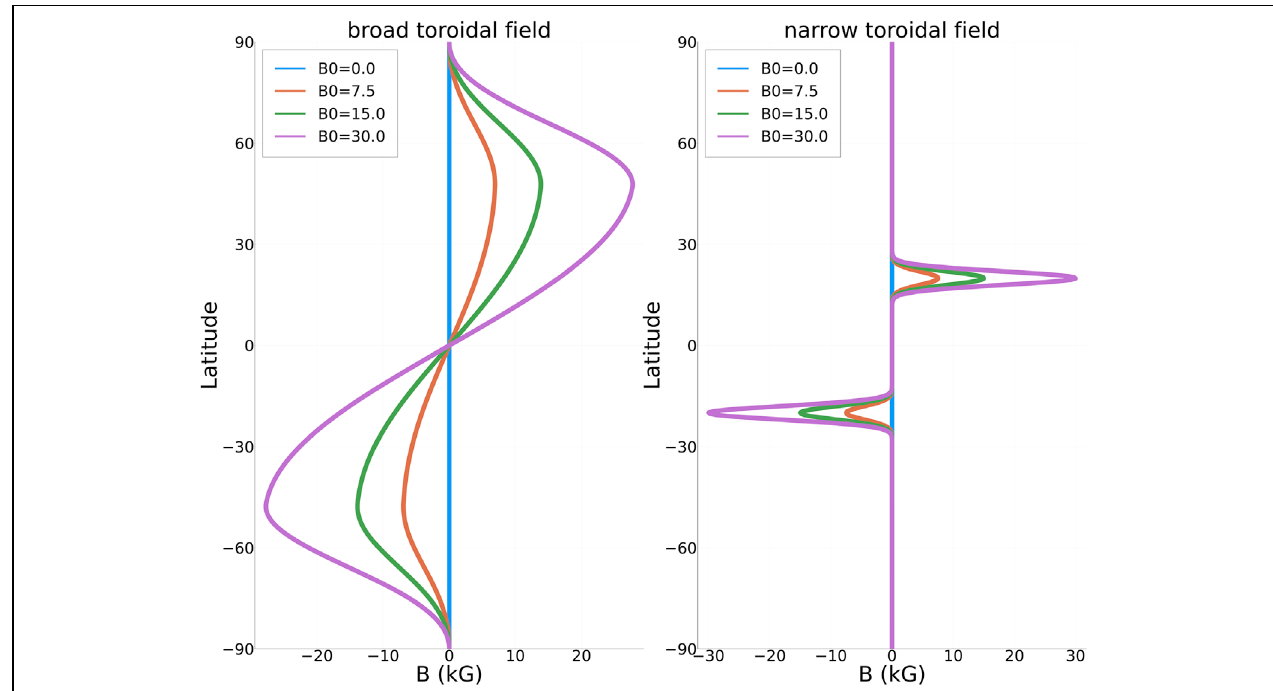
FIGURE 1 | Toroidal magnetic field profiles used in this study with varying maximum field strengths of B 0 = 0G, B 0 = 7,500G, B 0 = 15,000G and B 0 = 30,000G. On the left is a slowly decaying (as a function of the latitude) Gaussian profile; on the right is a narrow profile centred at 25 o of